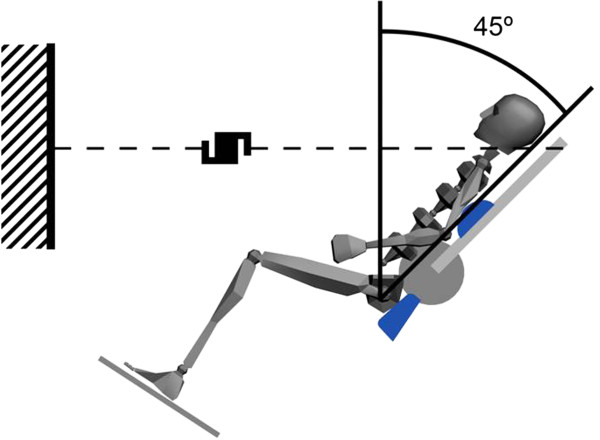
Scheme of the participants position and ejecution of the gesture analized.